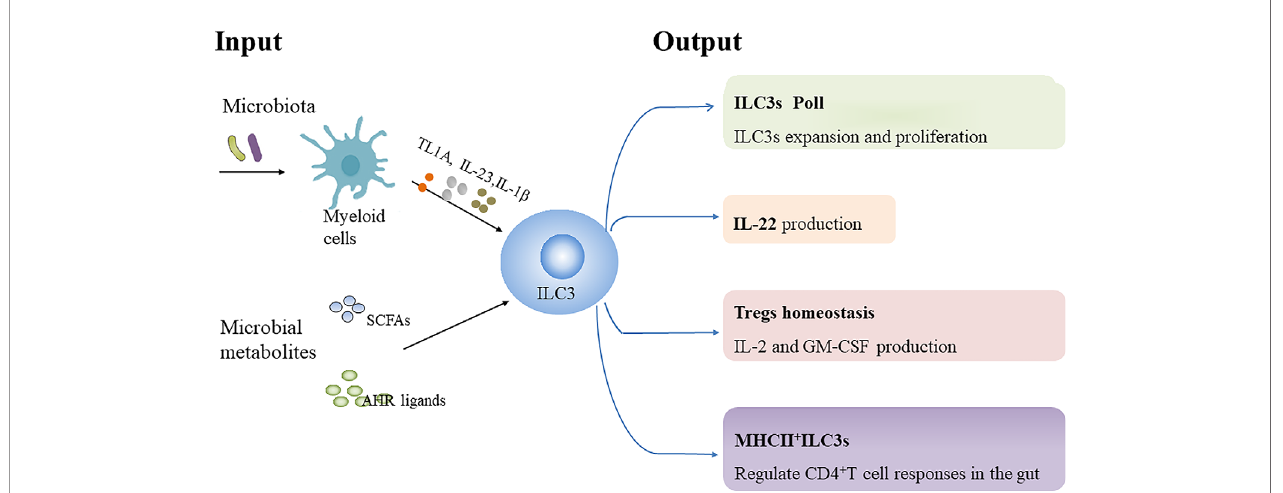
FIGURE 1 | Regulation of ILC3s by microbiota and microbial metabolites. Microbiota-driven IL-1 b production by intestinal macrophages enhances IL-2 and granulocyte macrophage colony-stimulating factor (GM-CSF) production by ILC3s, which is essential for regulatory T cells (Tregs) and immunologic homeostasis in the small intestine and colon in mice, respectively. Microbiota-induced IL-23 reduces major histocompatibility complex class II (MHCII) expression in murine NCR - ILC3s, thereby negatively affecting their potential to elicit CD4 + T cell responses. TNF-like ligand 1 A (TL1A) cooperates with IL-23 and IL-1 b to promote IL-22 production, proliferation and expansion of human ILC3s ex vivo . Additionally, TL1A can enhance IL-22 secretion by murine ILC3s. However, TL1A expression can induce OX40L expression in MHCII + ILC3s, which promote Th1 cells activation in chronic T cell colitis in mice. Collectively, microbial signals can be sensed by myeloid cells to regulate ILC3s biology. In addition, Short-chain fatty acids (SCFAs), the metabolites from gut microbial fermentation of dietary substrates, can regulate murine ILC3s pool as well as their IL-22 production in a receptor-dependent manner. Dietary tryptophan can be metabolized into aryl hydrocarbon receptor (AHR) ligands by commensal microbiota, which promote IL-22 secretion by murine